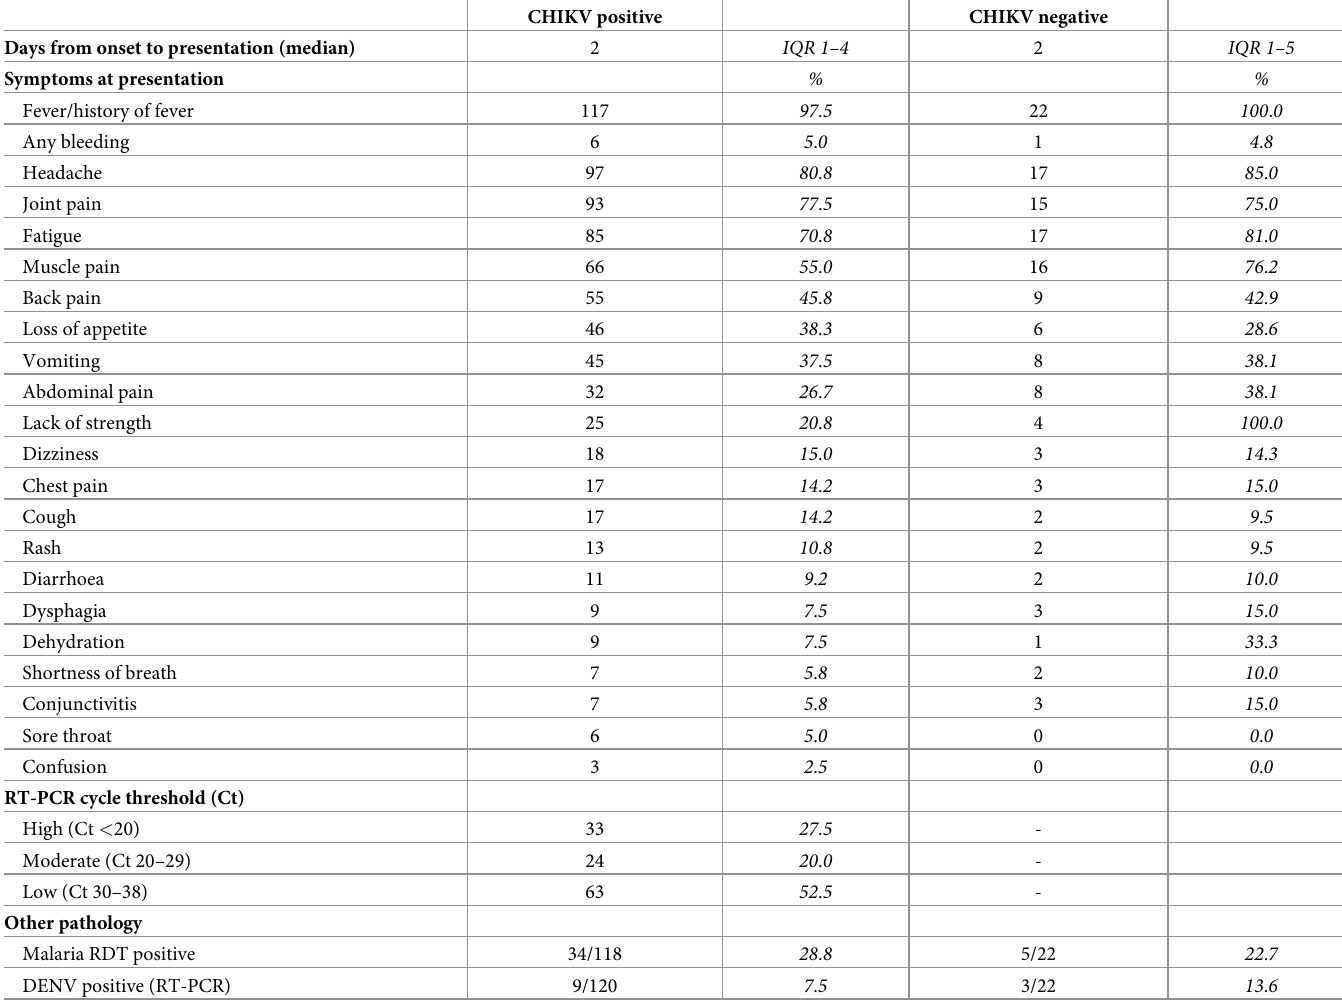
Table 2. Clinical symptoms and cycle threshold (Ct) values of participants at presentation by CHIKV RT-PCR result (n = 142). CHIKV